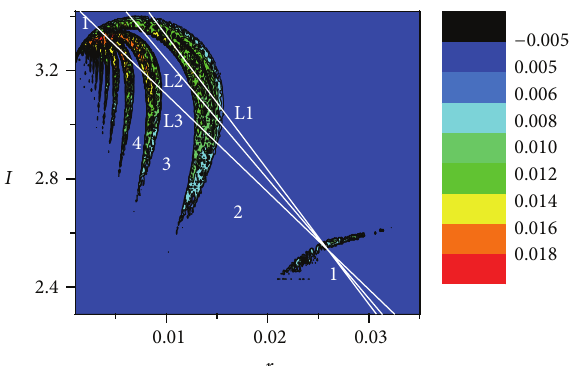
Figure 1: (Color online) the largest Lyapunov exponent in the 𝑟 × 𝐼 parameter space of the HR model ( 0.001 < 𝑟 < 0.035 , 2.3 < 𝐼 < 3.42 ).